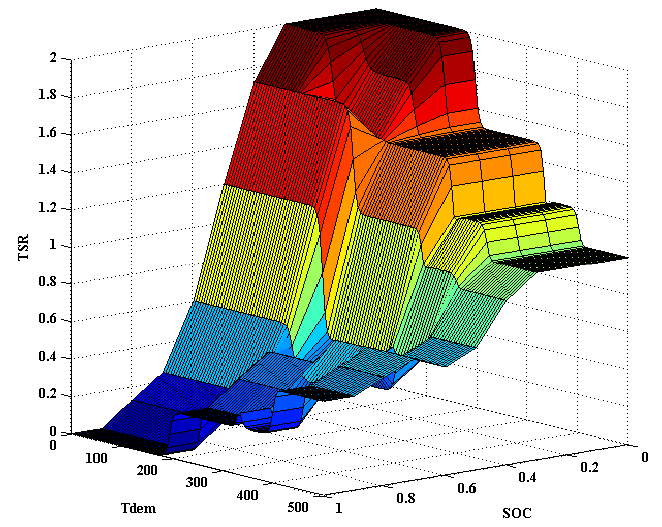
T ; and ( b ) initial membership functions of SOC . dem